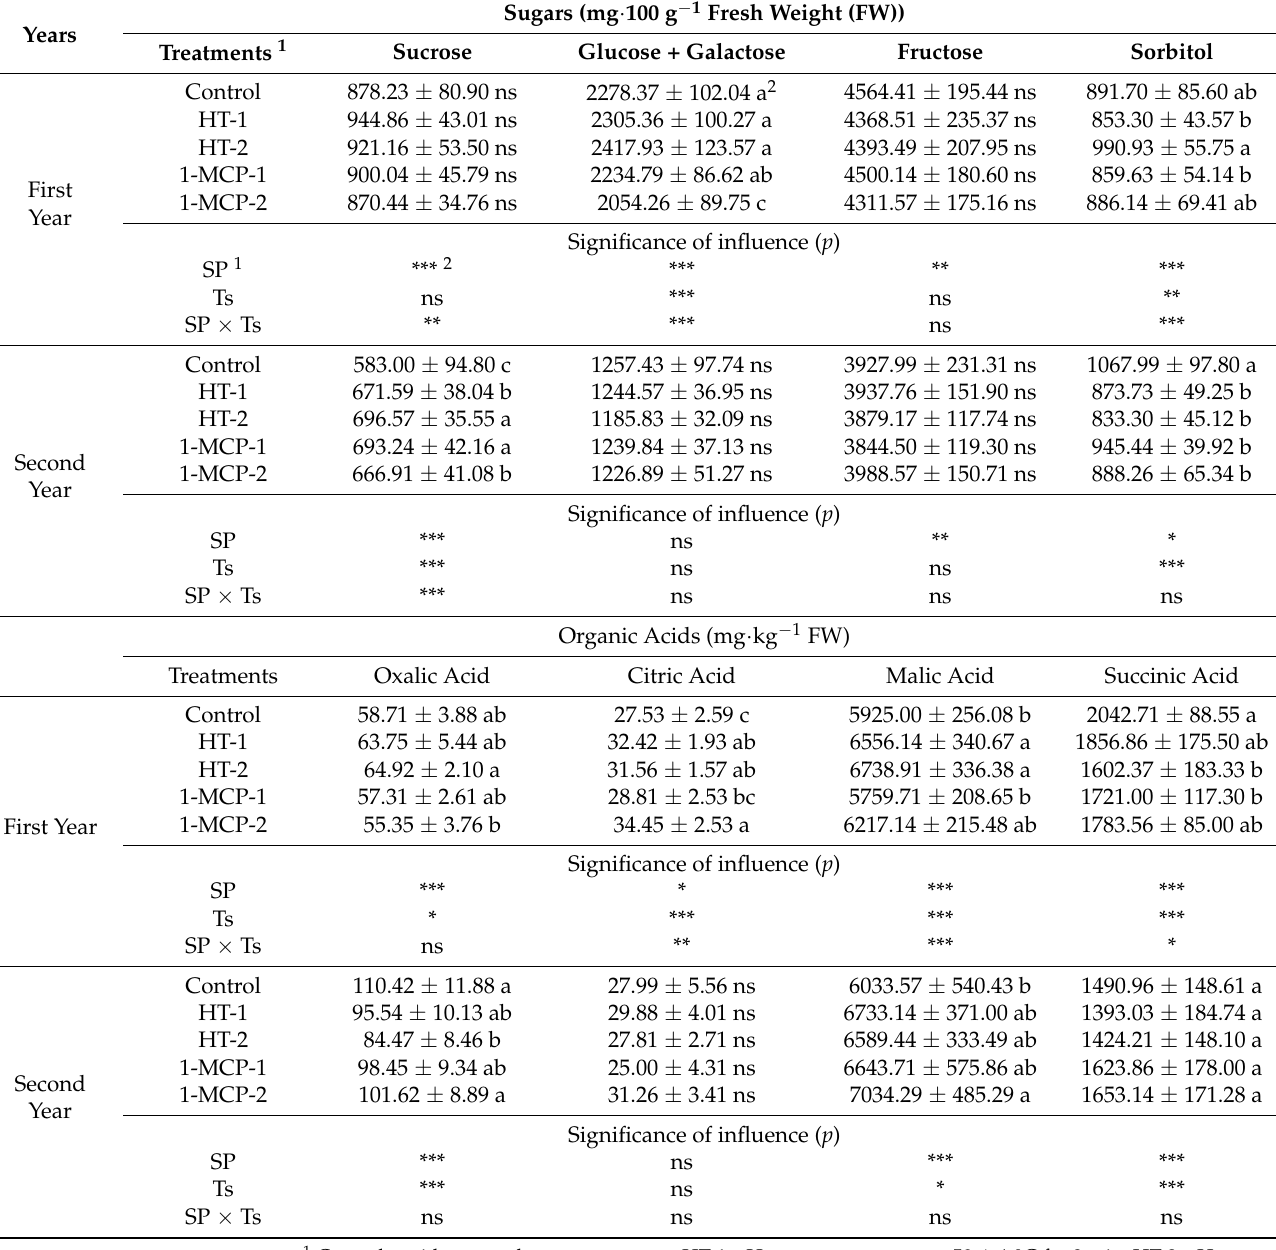
Table 2. The effect of different postharvest treatments on individual sugar and organic acid contents of quince